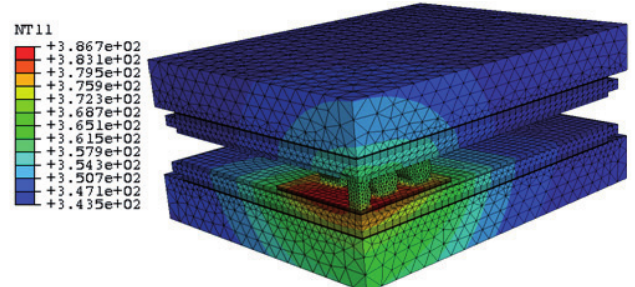
Fig. 14. Temperature distribution in solder bump assem- bly